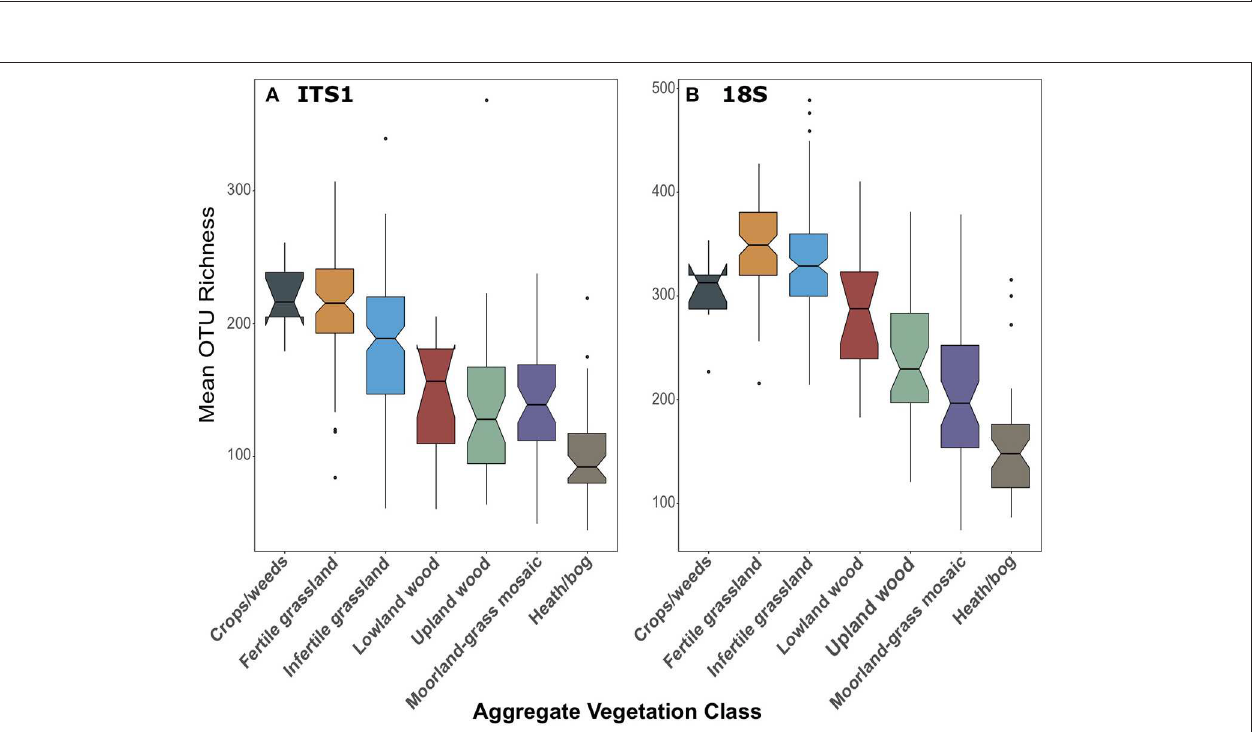
FIGURE 4 | Boxplots of fungal OTU richness for (A) ITS1 and (B) 18S datasets plotted against Aggregate Vegetation Class. Aggregate Vegetation Classes are ordered from most (Crops/weeds) to least (Heath/bog) productive. Boxes cover the first and third quartiles and horizontal lines denote the median. Black dots represent outliers beyond the whiskers, which cover 1.5X the interquartile range. Notches indicate confidence interval around the median. Overlapping notches are a proxy for non-significant differences between medians. Black dots are outliers.